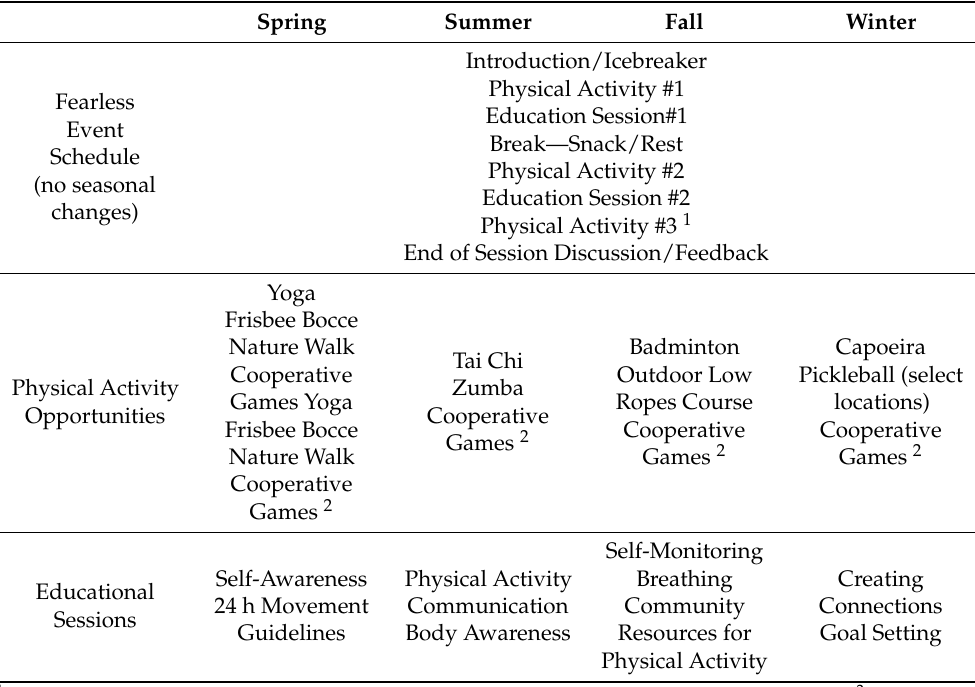
Table 3. Description and content of Fearless